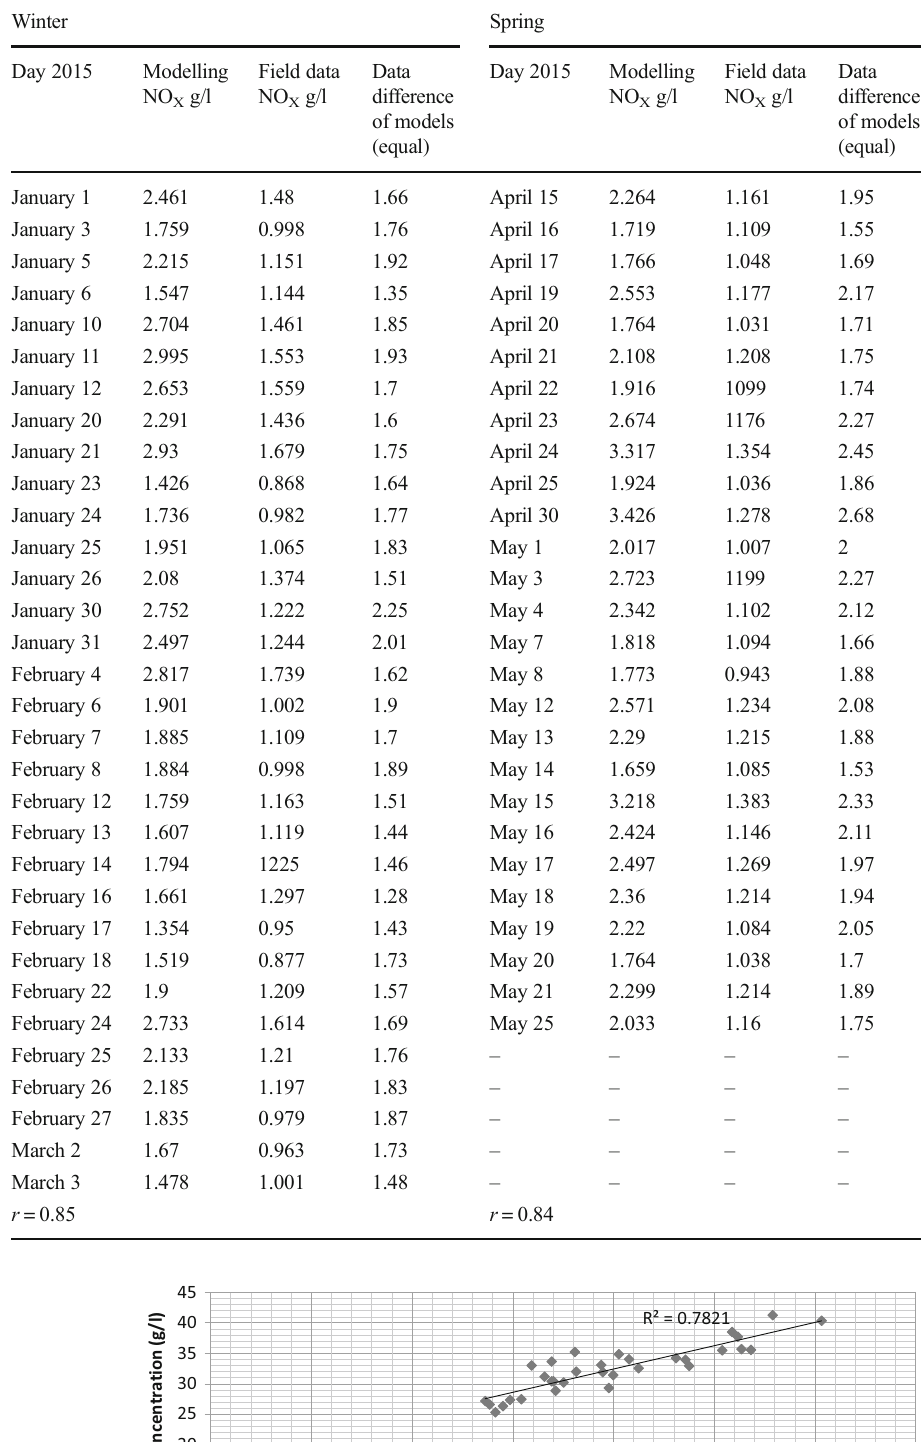
Table 4 Comparison of NO X emissions concentration of the model and Field data